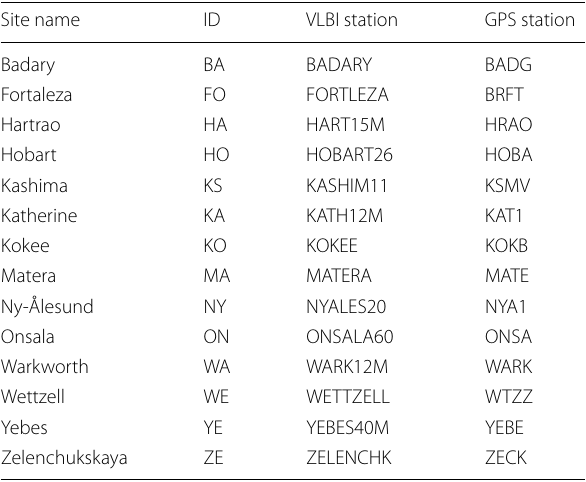
Table 1 Geodetic core sites of the Legacy‑1 network used in this